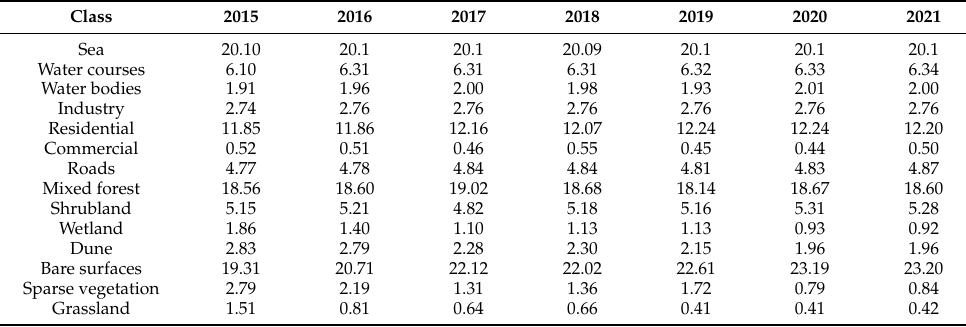
Figure 8. Maps of the class-based classification for the study period (2015–2021). Units: meters. Projection: WGS84 / UTM Zone 15N. Table 9. Percentage area estimated for the class-based